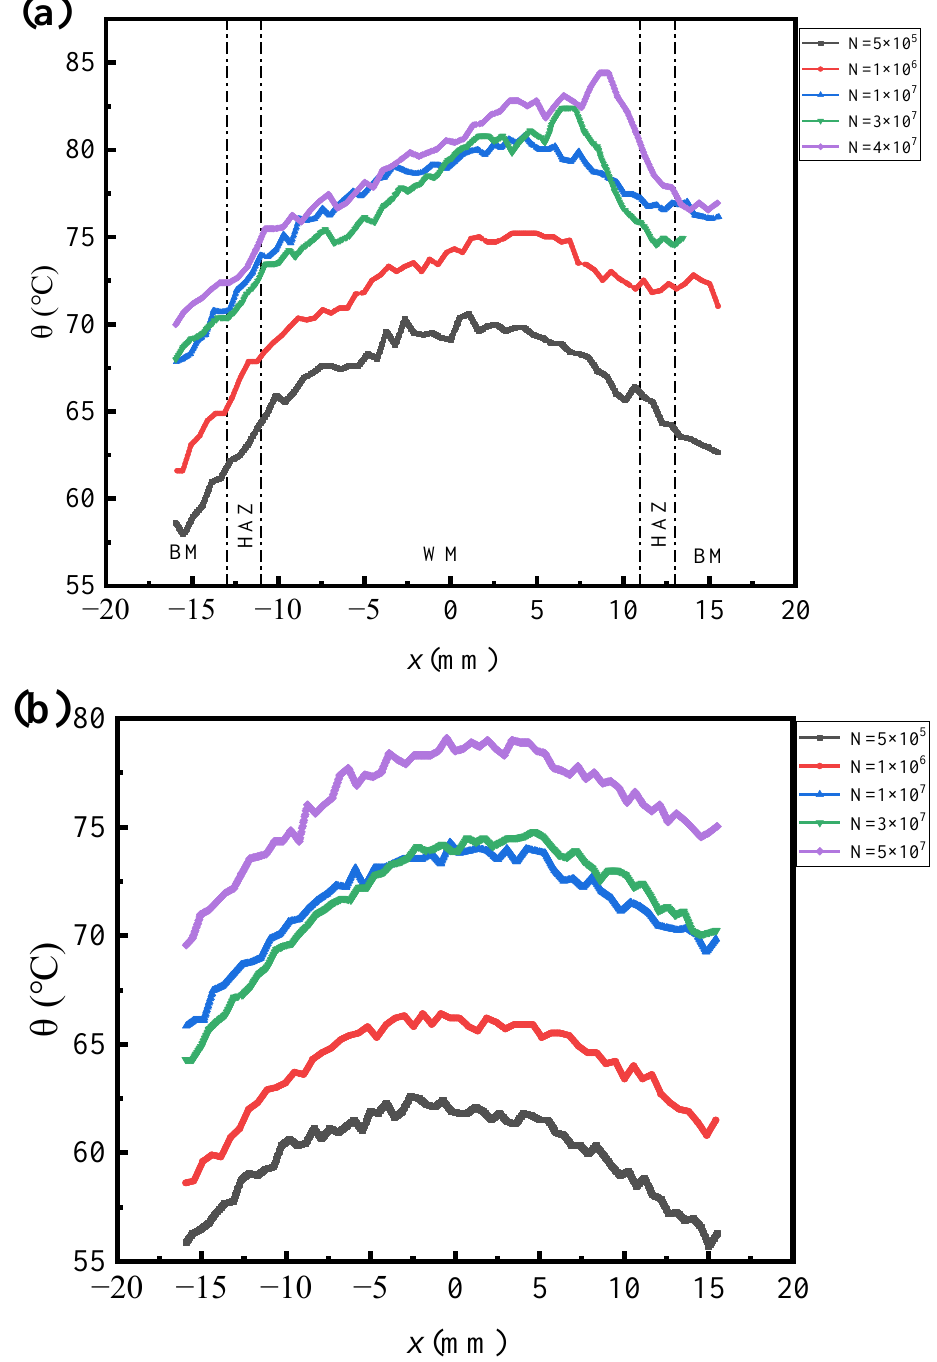
Figure 8. Specimen surface temperature distribution along axial direction of welded joint and BM specimens at a = 645 MPa: ( a ) welded joint, ( b ) base metal.